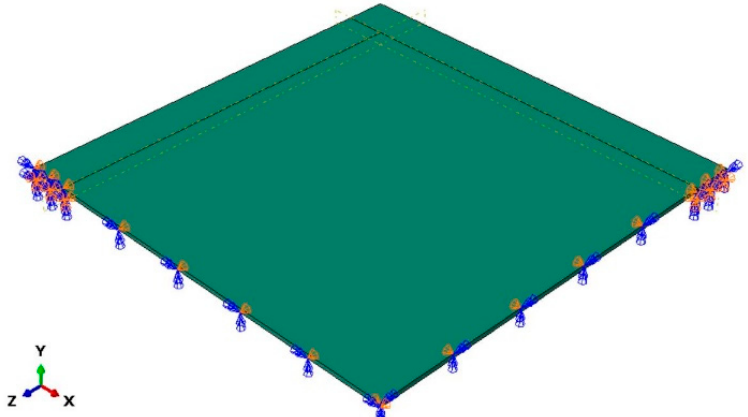
Figure 8. General view (1/4th the nominal geometry) of the reference FE numerical model (ABAQUS/Standard).